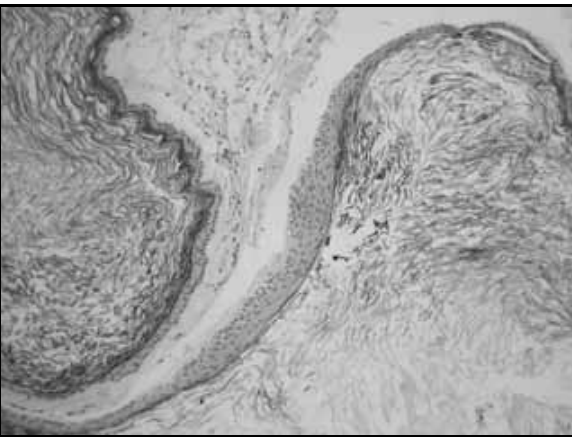
Figure 2 – Epidermoid cyst: cystic lesion lined by a thin layer of squamous epithelium and filled with keratinous debris (hematoxylin-eosin,